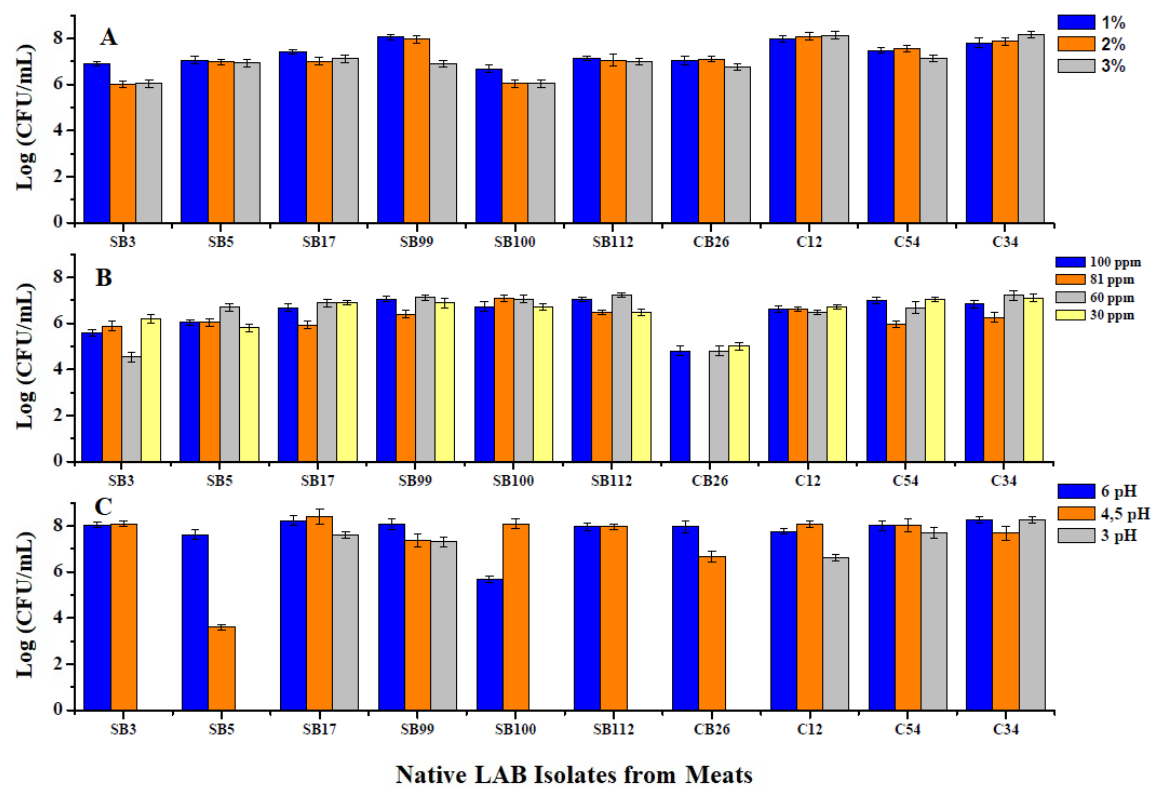
Figure 1. Viability of the 10 native LAB at different concentrations of NaCl ( A ), nitrite and nitrate salts ( B ), and different pH values ( C ).